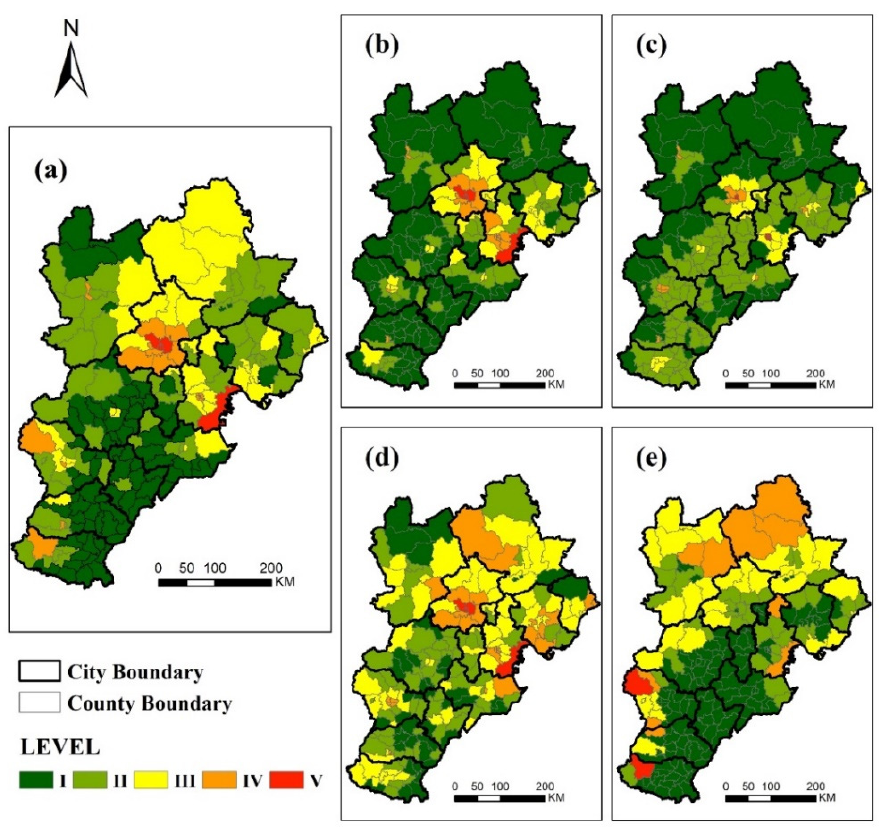
Figure 5. Urban quality rating chart of the BTH region: ( a ) Comprehensive urban quality; ( b ) economic capability; ( c ) population capability; ( d ) social capability; ( e ) environmental capability.